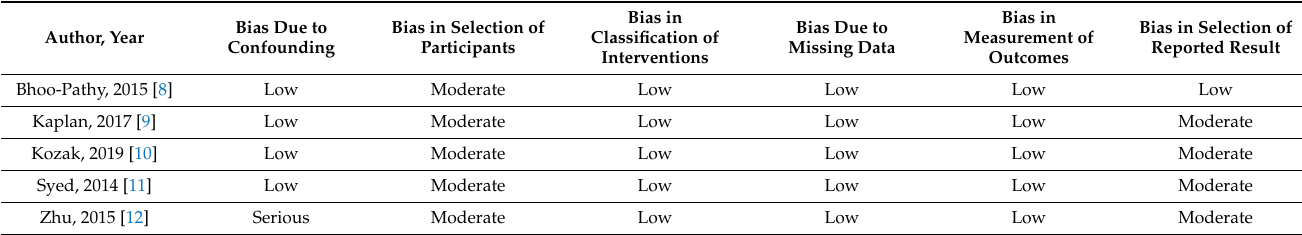
Table 1. The Risk of Bias in Non-Randomized Studies of Interventions (ROBINS-I) assessment tool for included studies. Author,